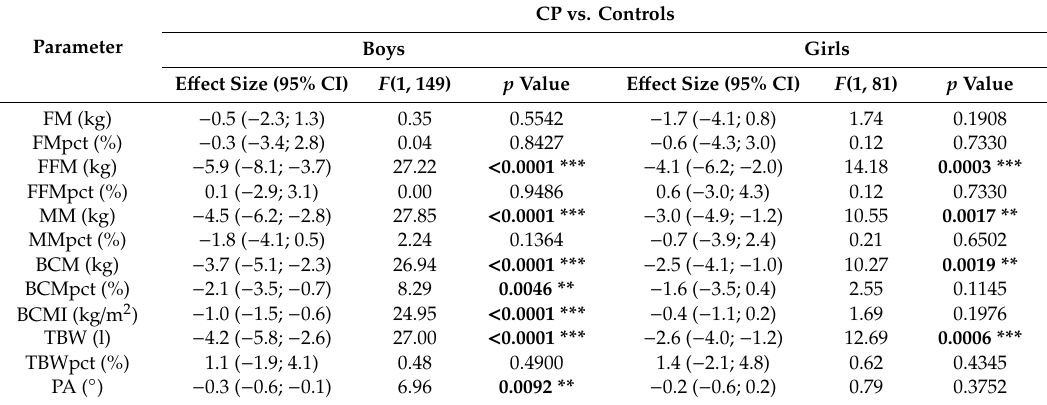
Table 3. Comparison of BIA results in study and control groups according to gender - estimation of di ff erence between CP and controls using ANCOVA model with age as covariate. CP vs. Parameter